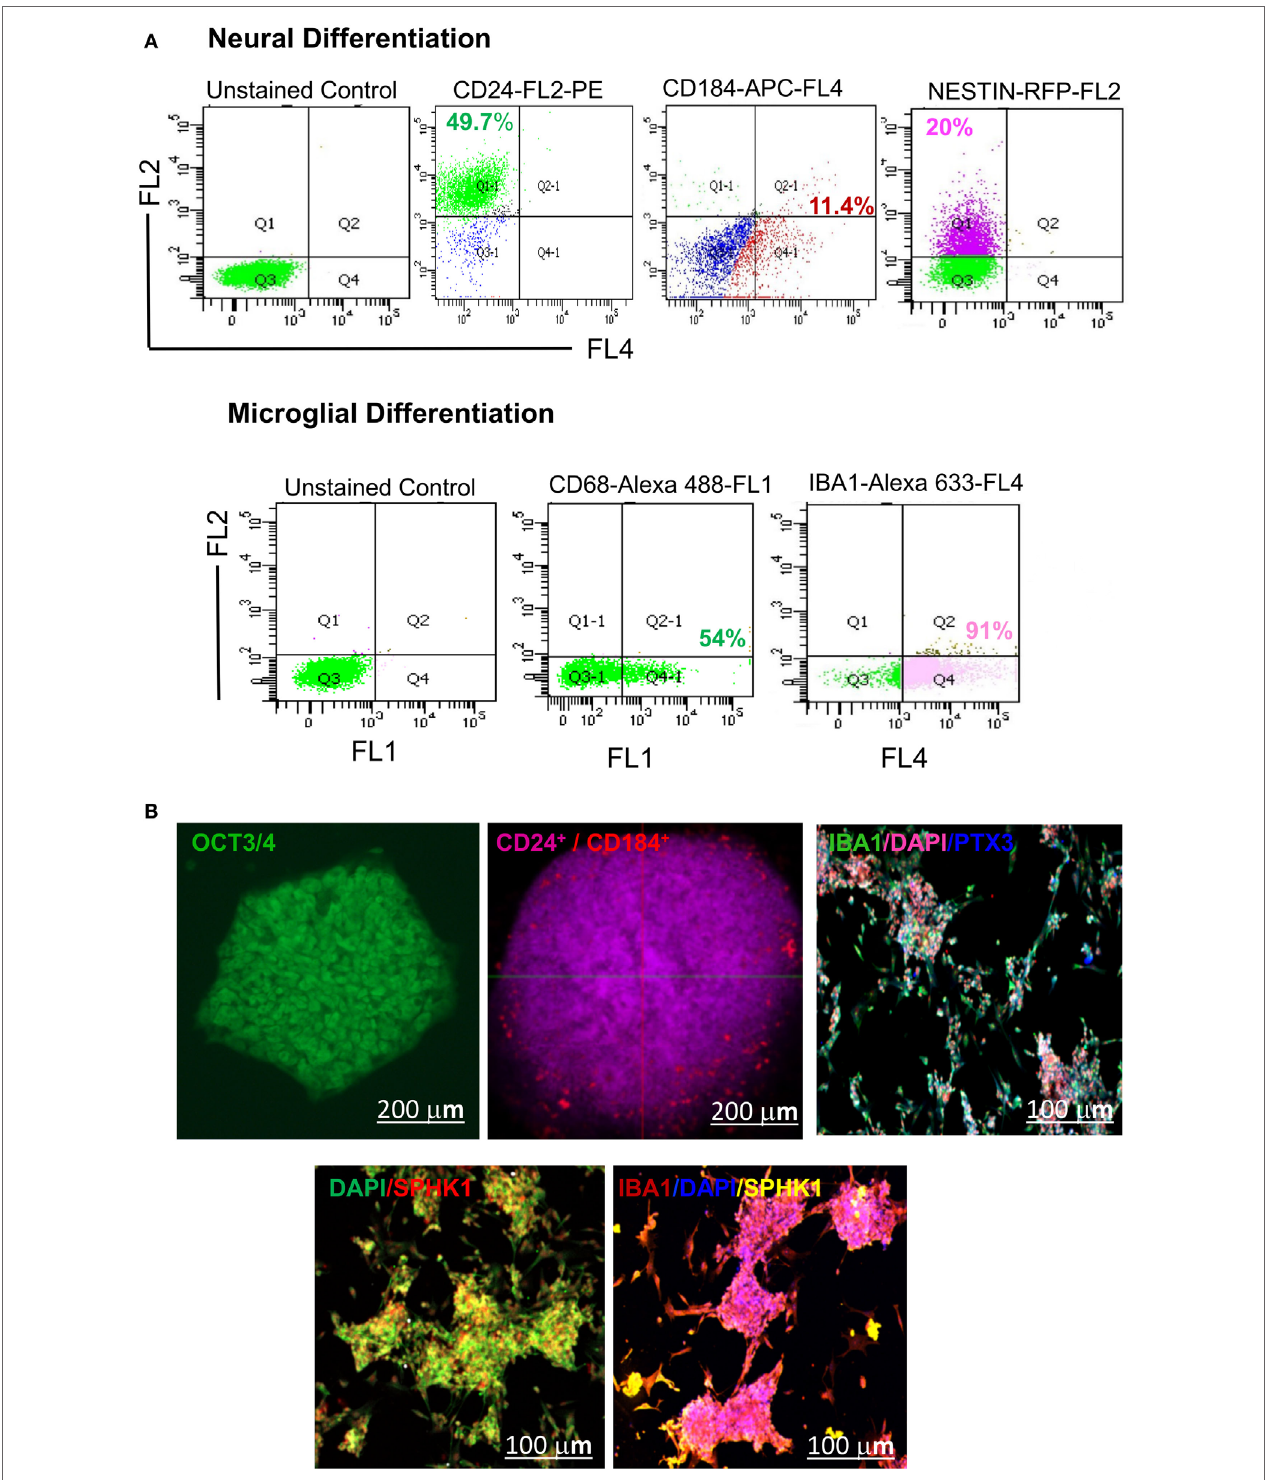
FigUre 10 | Identification of hESC-derived microglia precursors in vitro using different stage-specific markers. (a) Flow cytometry based analysis demonstrated characterization of microglia induction and differentiation of microglial precursors. The analysis indicated differentiation of hESCs into embryonic bodies (EB, 5 DIV), as shown by expression of ~49.7% CD24 Pos and 11.4% CD184 Pos population. This is followed by neural induction as shown by 20% of NESTIN Pos cells. Neurally induced cells further showed the generation of a distinct population having 54% of CD68 Pos cells and 91% IBA1 Pos cells. (B) Confocal imaging of hESC-derived EBs showed expression of CD24 and CD184 in vitro at 5 DIV. The emergence of mature microglial precursors could be detected on 34DIV, as shown by IBA1 , SPHK1 , and PTX3 expression. DAPI = nuclear marker, DIV = days in vitro . The scale bar represents size in micrometers.